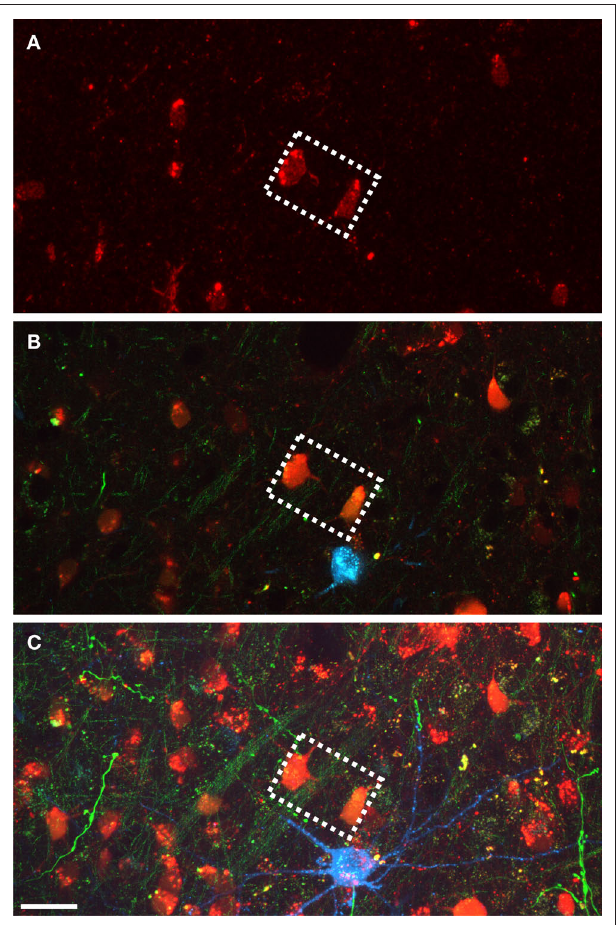
Figure 3 | Comparison of post-embedding tracer immunolabeling and pre-embedding confocal microscopy. (A) Immunolabeling of tracer on ultrathin HVC section. Anti-Lucifer yellow was used as the primary antibody. (B) Confocal optical slice of the same region as in (A) , imaged prior to preparation of the tissue for TEM imaging. The selection of the optical section was based on the shape and location of the cells in the white dashed rectangle (no corrective image transformations were performed). (C) Maximum projection of a confocal image stack of 60 optical sections. Scale bar: 25